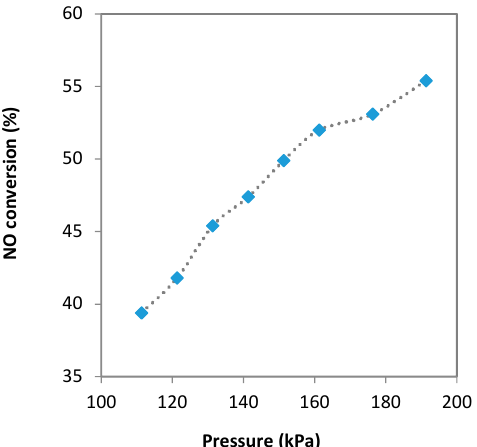
Figure 13. The dependence of NO conversion on pressure over the 2K / Mg0.2 catalyst. Conditions: 1000 ppm NO balanced by N 2 and GHSV = 6 L g − 1 h − 1 .